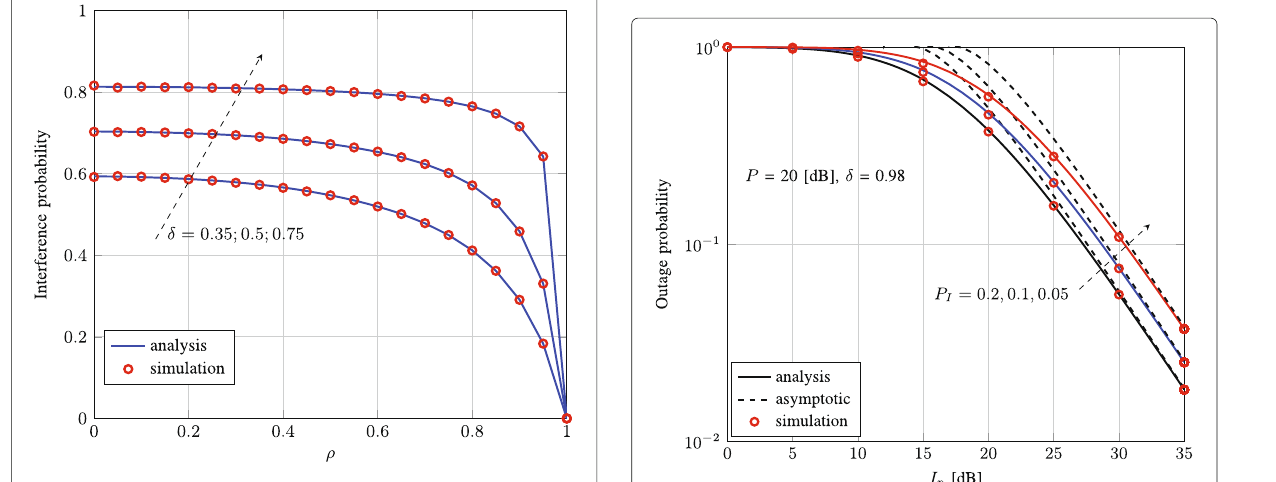
Fig. 2 Effect of the correlation coefficient on the interference probability P I to the primary receiver